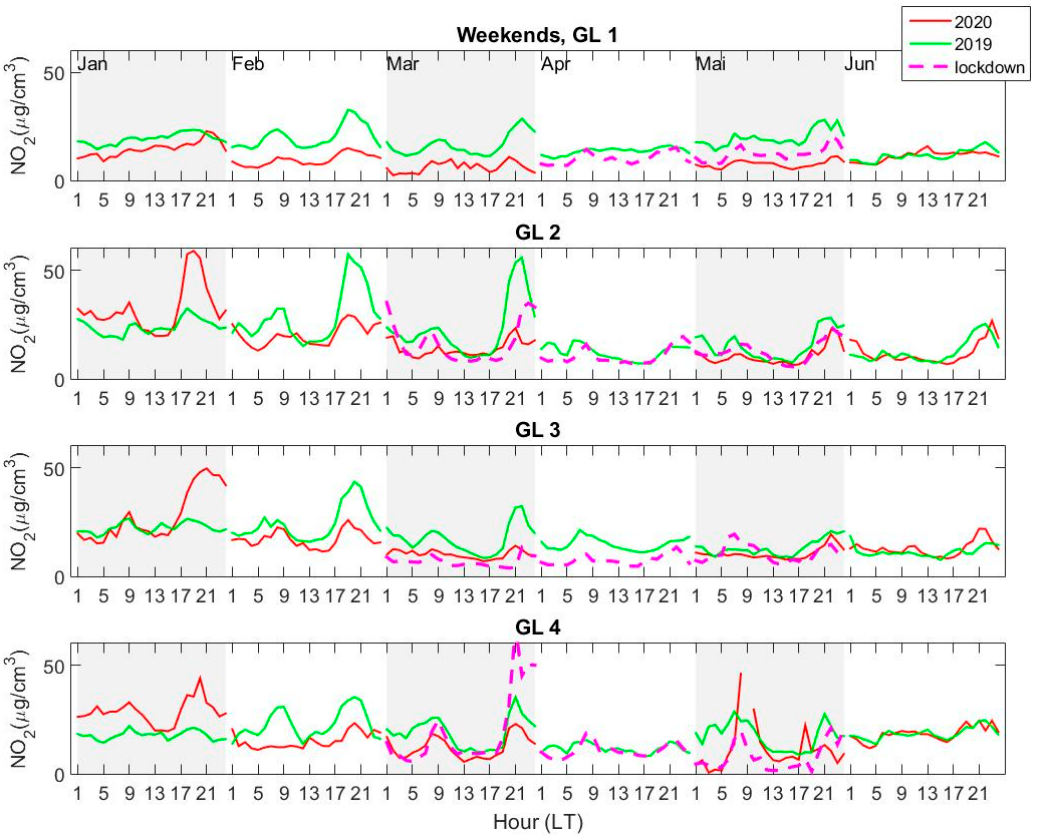
Figure 6. Similar to Figure 5, but for weekends (Saturday, Sunday): 2019—green line; 2020—red line; lockdown (23 March–15 May 2020)—magenta dash line.